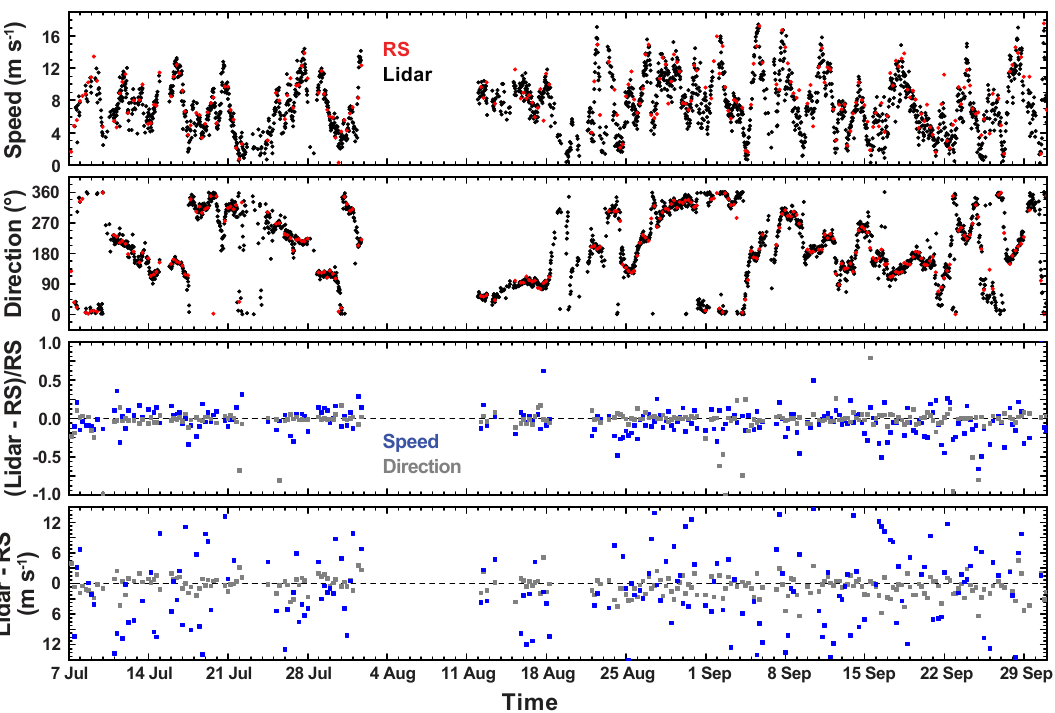
Figure 6. Time series of lidar (black, every 50min) and radiosonde (red, every 6h) wind speed (top) and wind direction (middle) at 100ma . s . l . The lower two panels show the relative and absolute difference for wind speed (blue) and direction